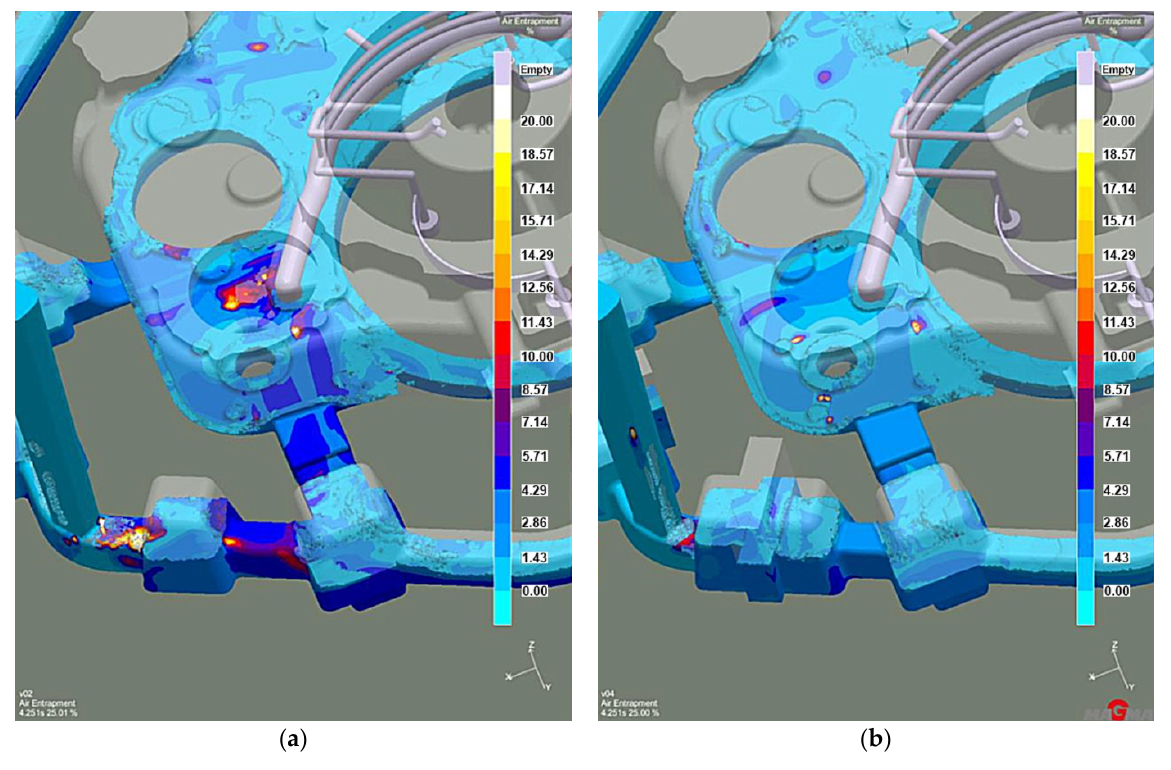
Figure 12. Stage 3-( a ) Filter system without ceramic filters; ( b ) Filter system with ceramic filters. The gravity top feeding system is used in the fourth stage of the simulation. Risers occur in the hot node’s main areas and exits of the oxidized liquid alloy front (Figure 13).